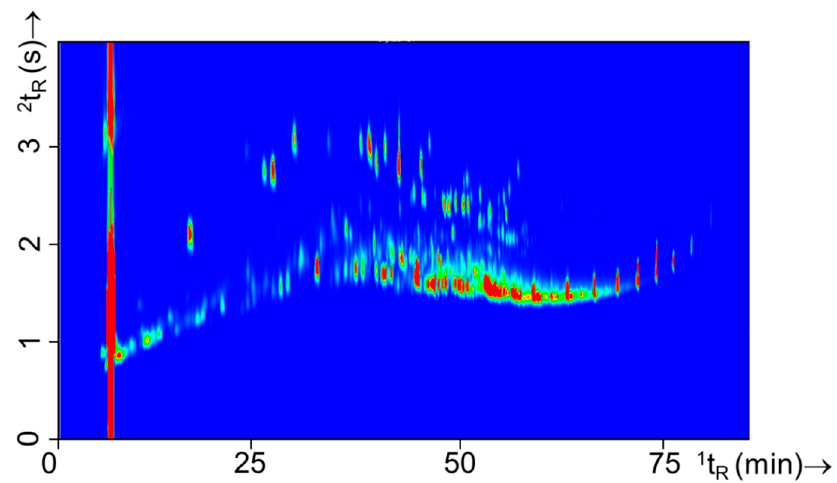
Figure 4. GC×GC-FID contour plot of IL mixture under optimized separation